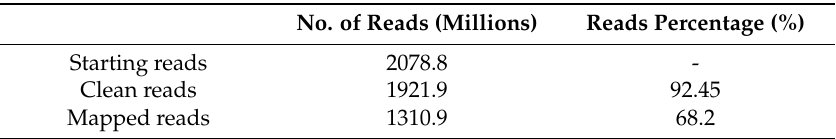
Table 1. The starting reads, clean reads ratio, and mapped reads ratio against in the B. napus reference genome of c.v. Darmor-bzh